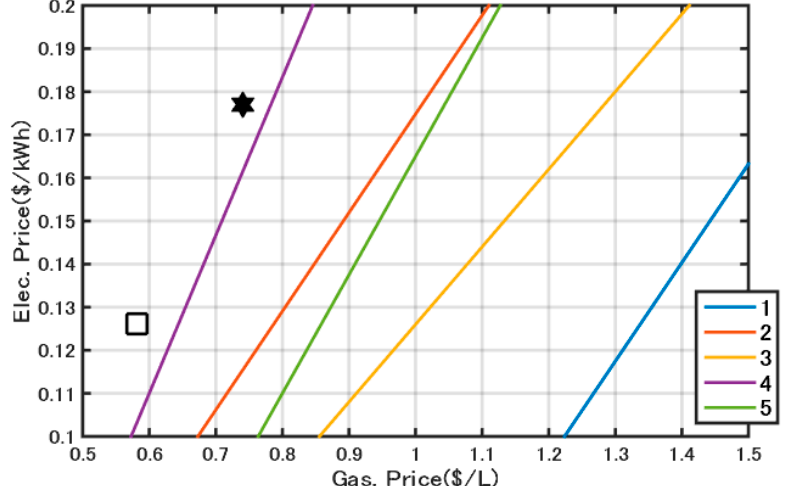
Figure 10. Two-dimensional diagram summarizing the LCC comparison shown in Figure 9. The relationships between points representing specific regions and threshold lines for each setting in Figure 9 are depicted for a difference in the vehicle price of $1000, that is, the diagram corresponds to the base of the cubes for the LCC space in Figure 9.